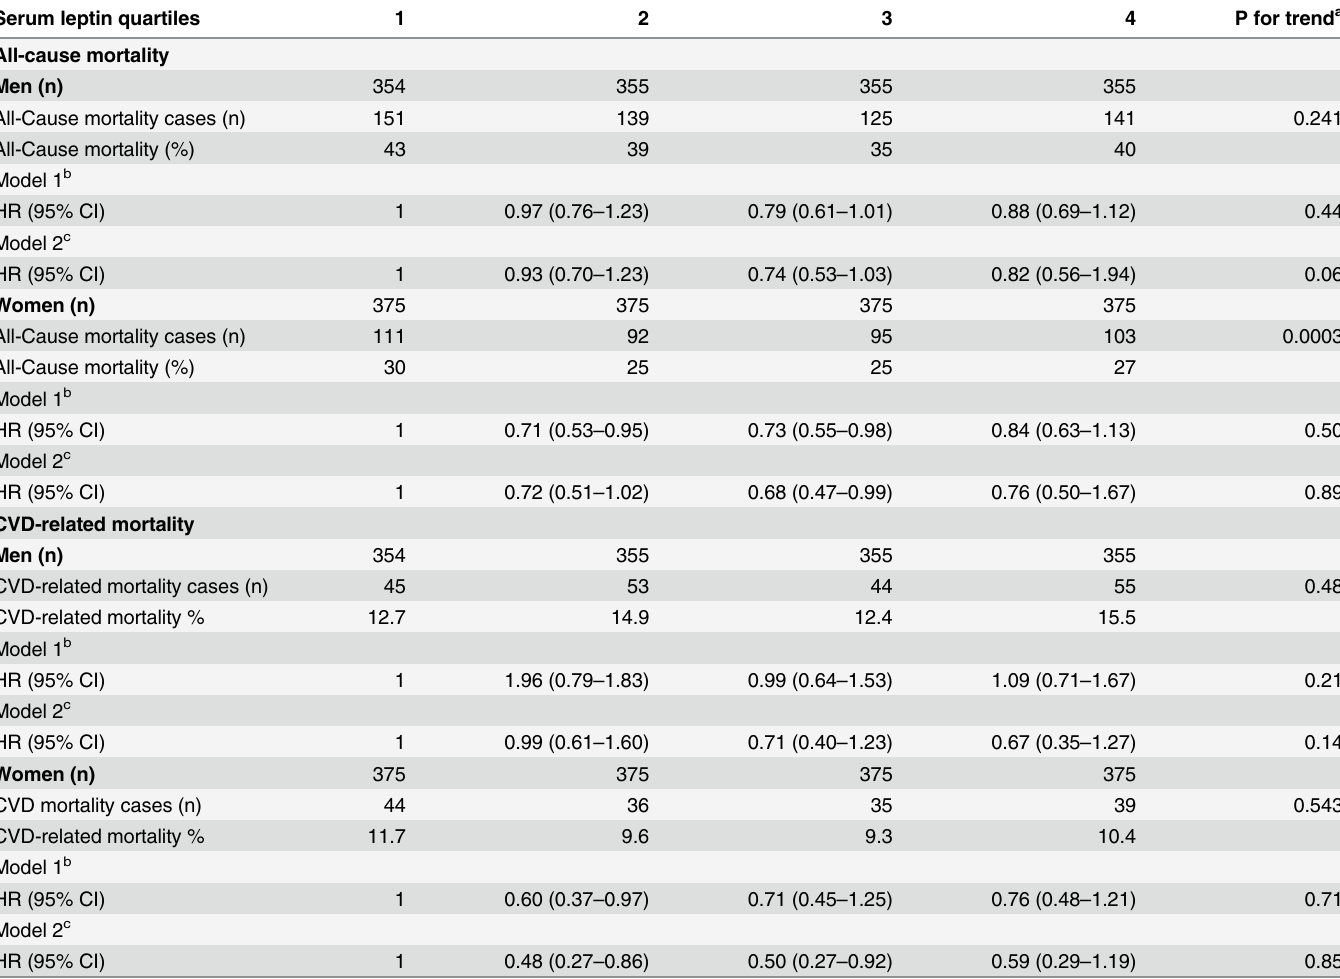
Table 3. Hazard ratios (HR) for all-cause mortality and CVD-related mortality by serum leptin